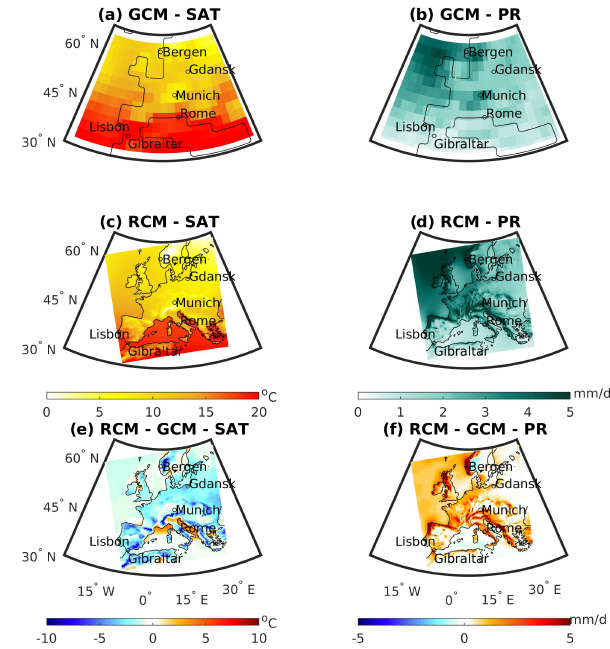
Figure 1. Ensemble mean surface air temperature (SAT) and pre- cipitation in the GCM (a, b) and RCM (c, d) SMILEs over Eu- rope at 1K warming (2002). The difference between the RCM and GCM SMILEs is shown in (e) and (f) . We use an 11-year window around the warming year to analyse the data. The cities investigated in Figs. 3 and 4 are shown on the maps. Continental borders are plotted for each model’s native